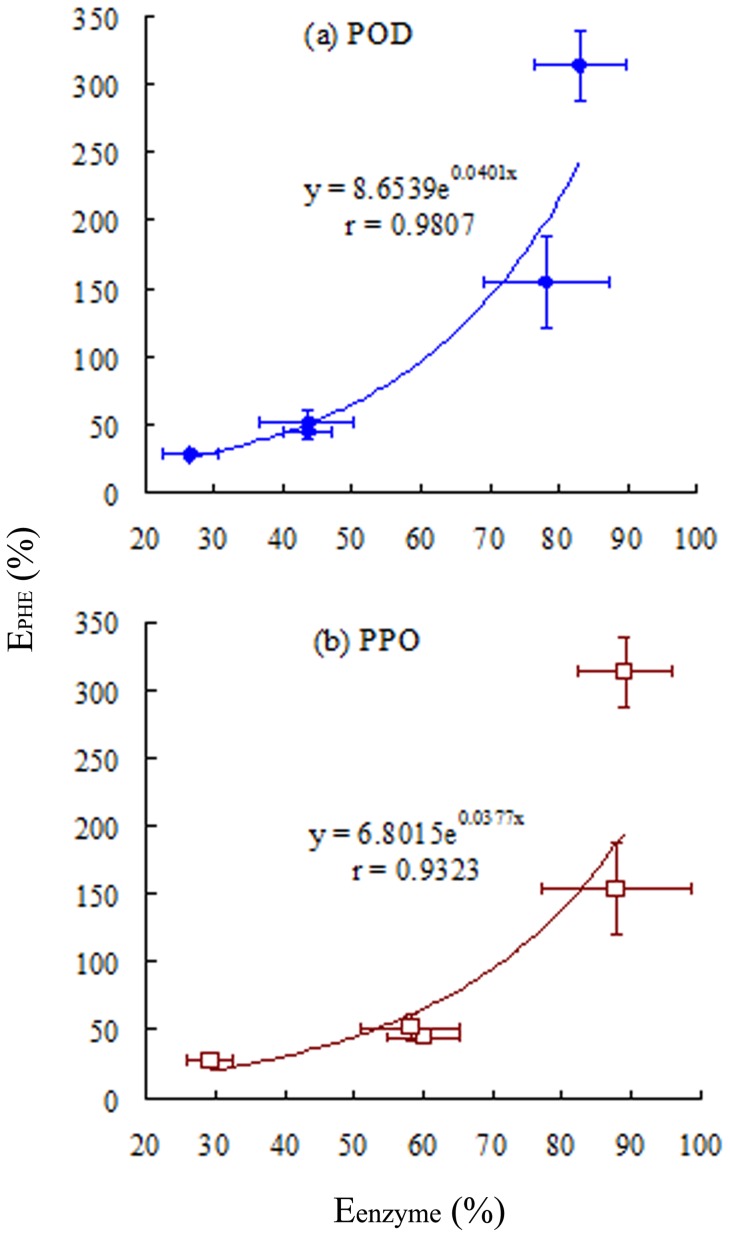
Relationship between EPHE and Eenzyme for (a) POD and (b) PPO.EPHE and Eenzyme are the inhibition efficiencies of ascorbic acid on phenanthrene degradation and enzyme activities in plant roots, respectively. EPHE was calculated as: EPHE (%)  =  (CPHE-AA–CPHE-c)/CPHE-c×100%, where CPHE-c and CPHE-AA represent the phenanthrene concentrations in plant roots grown without and with AA, respectively. Eenzyme was calculated as: Eenzyme  =  (Uc–UAA)/Uc×100%, where UAA and Uc represent the enzyme activities in plant roots grown in the presence and absence of AA, respectively. Error bars represent standard deviations (SD).